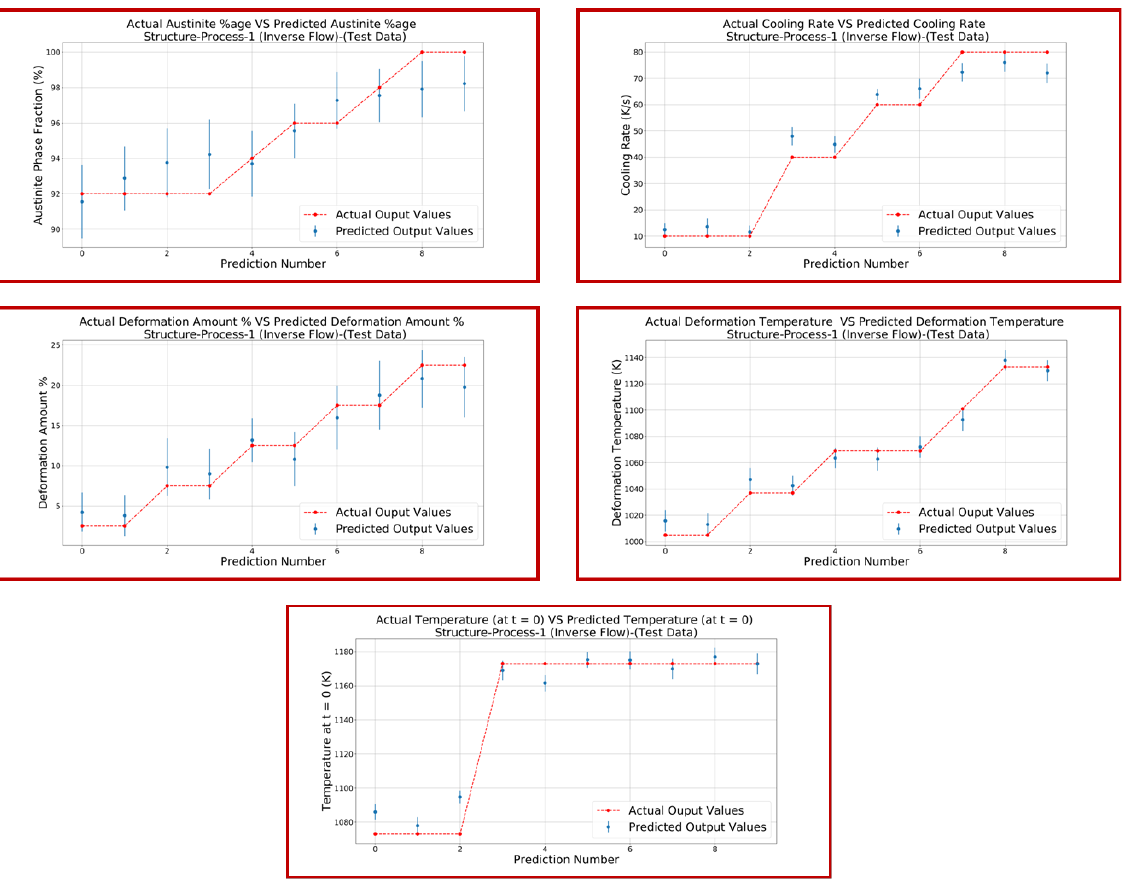
Figure 11. Predicted Output and Actual Output Comparison for Step 3.1 (for Test Dataset). Table 11. Processing Parameter Combinations Satisfying Microstructure Requirements. Combinations of the Processing Parameters (Forming and Quenching Phase) Identified